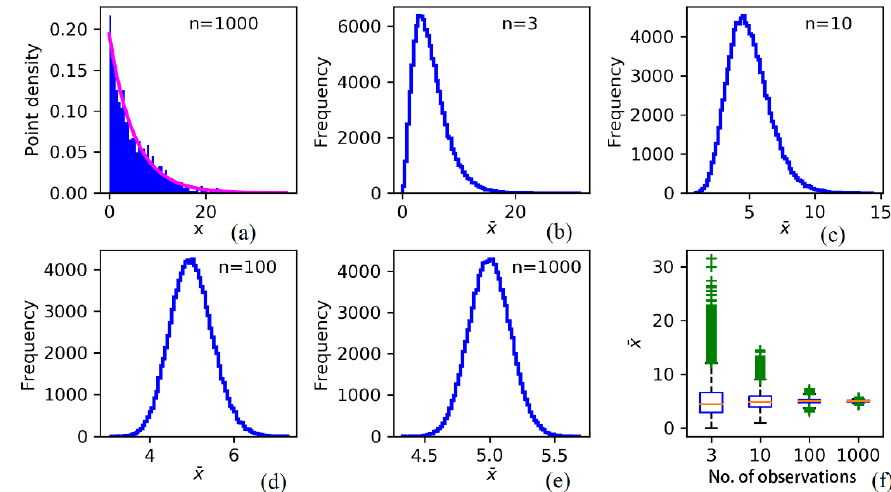
Figure 1. Demonstration of the Central Limit Theorem (CLT): (a) histogram of a 1D synthetic data set, follows an Exponential distribution with mean 5. 10 5 samples of sizes 3, 10, 100 and 1,000 are drawn, means are 𝑥̅ ; line diagrams of frequency versus 𝑥̅ for: (b) n =3, (c) n =10, (d) n =100, and (e) n =1000, plots show that 𝑥̅ with an increasing number of points follows Normal distribution, (f) boxplots for the means ( 𝑥̅ ) of different sizes of